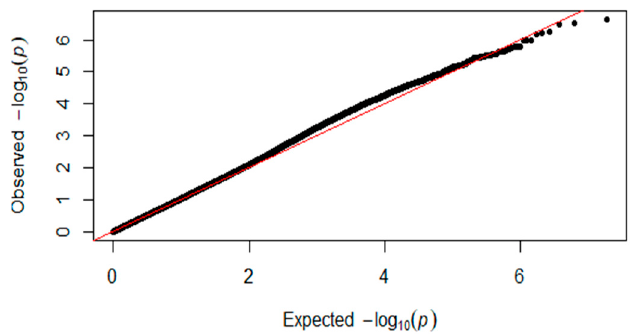
Figure 1. Quantile–quantile plots of p -values for muscle glycogen. The x-axis is the expected − log10 p -value and the y-axis is the observed − log10 p -value.